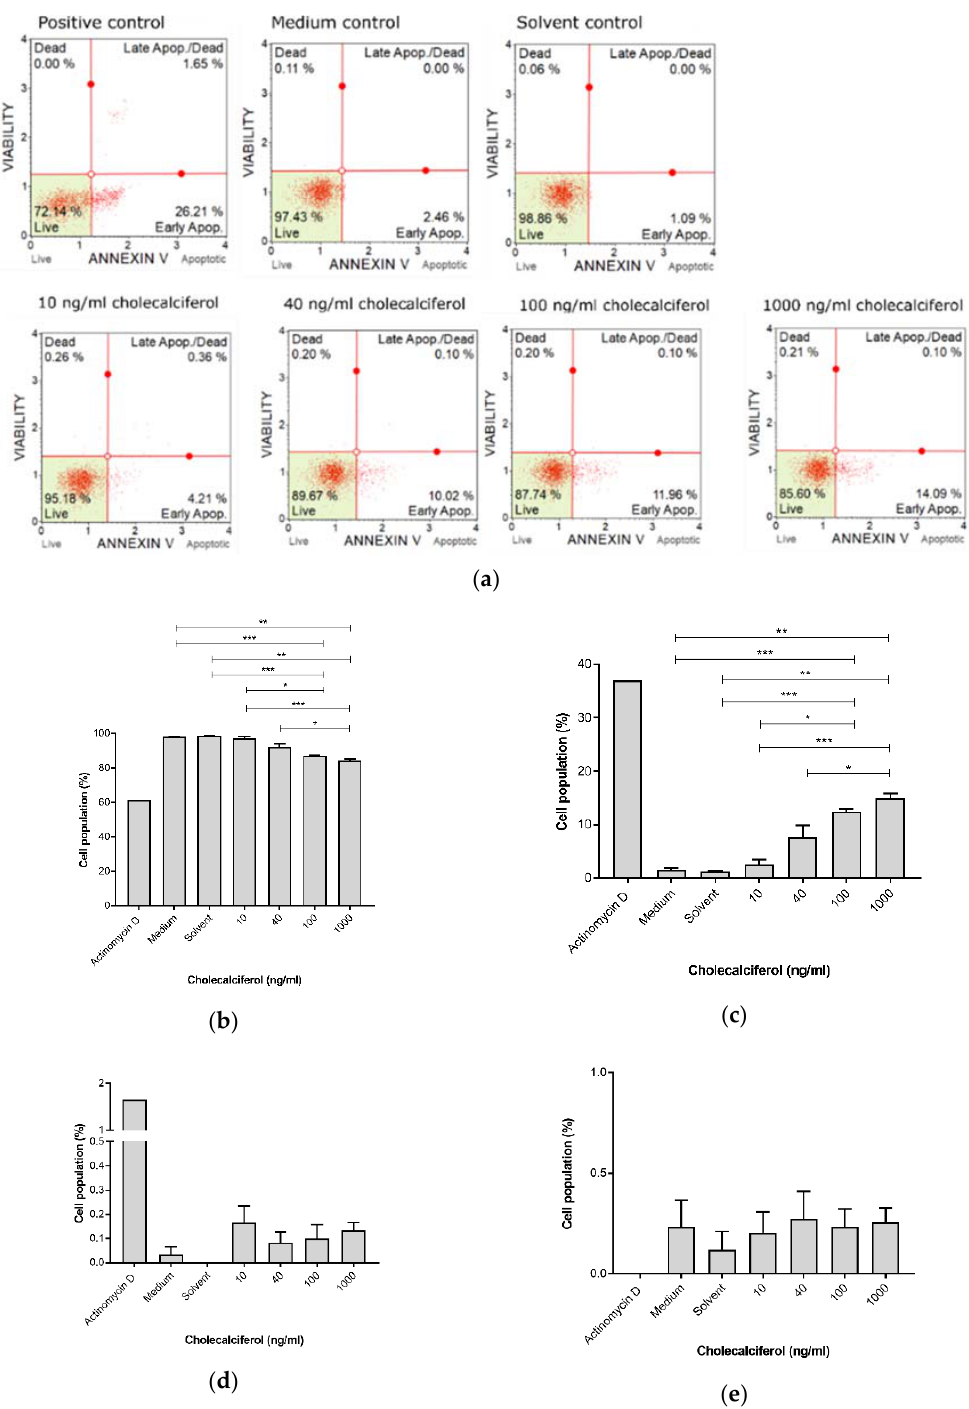
Figure 4. Early biochemical apoptosis in the control and experimental CaSki cultures, using the Muse™ Annexin V assay. ( a ) Two ‐ dimensional dot ‐ plot diagrams, and cell populations. ( b ) Live cells. ( c ) Cells in early apoptosis. ( d ) Cells in late apoptosis and ( e ) dead cells. Cholecalciferol significantly decreased the live cell population and increased the proportion of cells in early apoptosis at 100 and 1000 ng/mL in comparison to the low ‐ dose treatments and control cultures. Assays were performed on three biological replicates, and each replicate was technically triplicated. Values are expressed as mean ± SEM ( p < 0.05 was considered statistically significant). * p < 0.05; ** p < 0.01; *** p < 0.001.